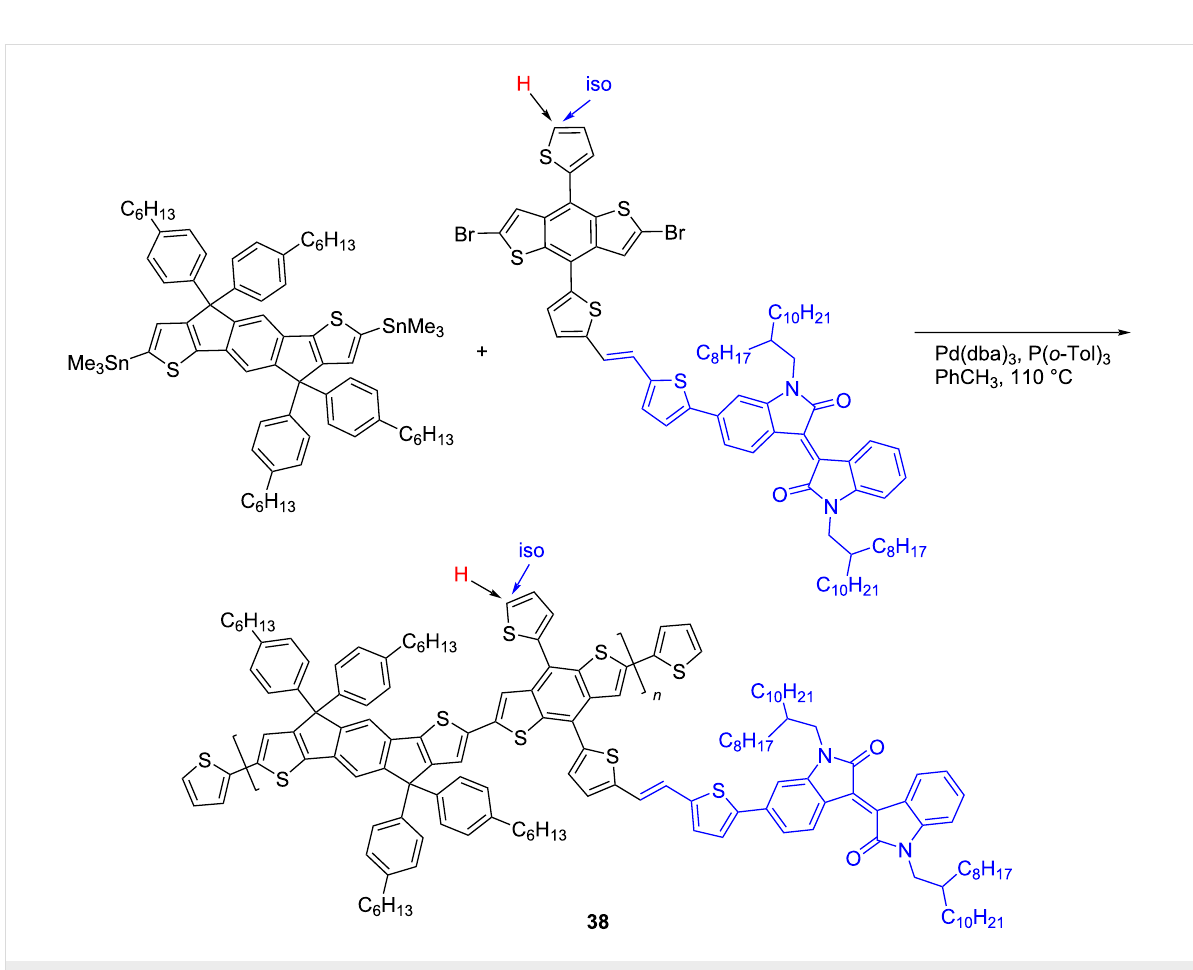
Scheme 21: Polymers with isoindigo substituent as side-chain photon